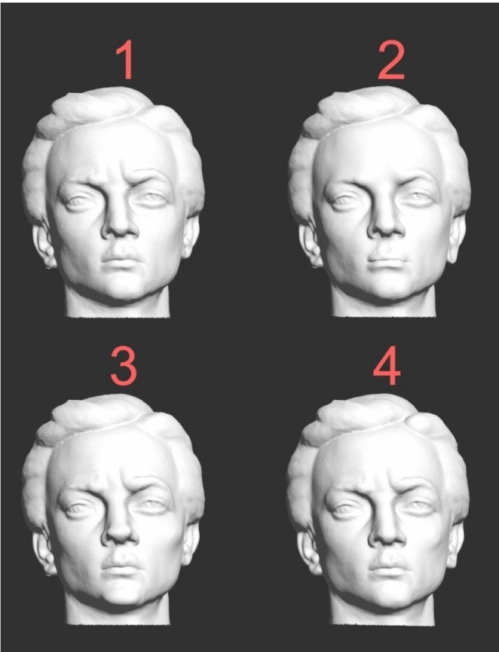
Figure 15. The composition of different sculptures used for the survey: 1 is original sculpture, 2 and 3 are sculptures that are deformed in Zbrush, 4 is the sculpture with the digital